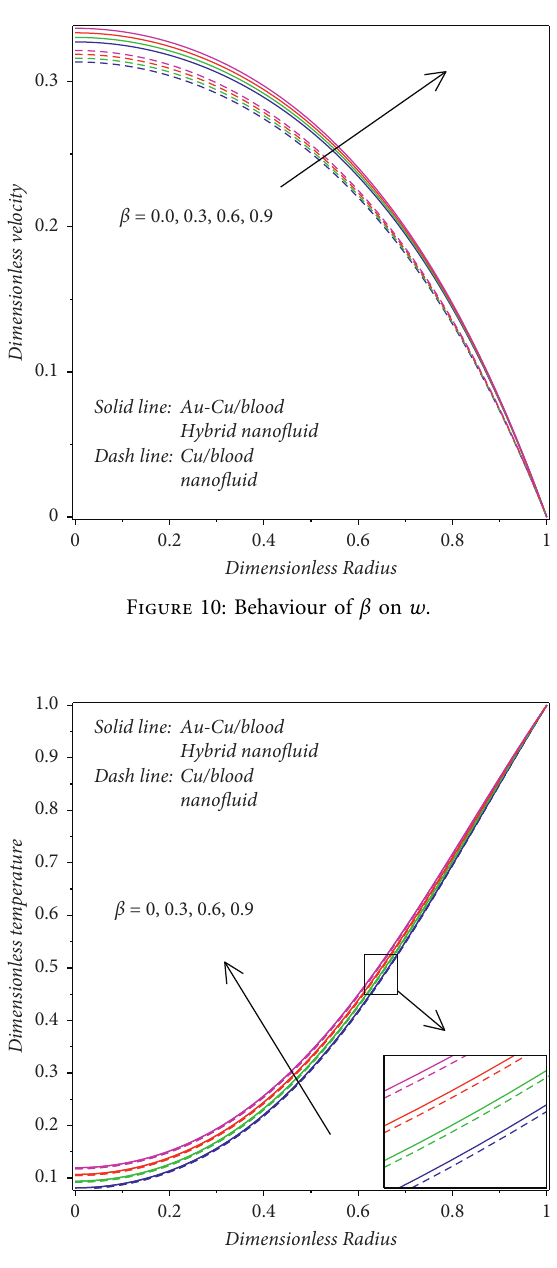
Figure 11: Behaviour of β on θ .